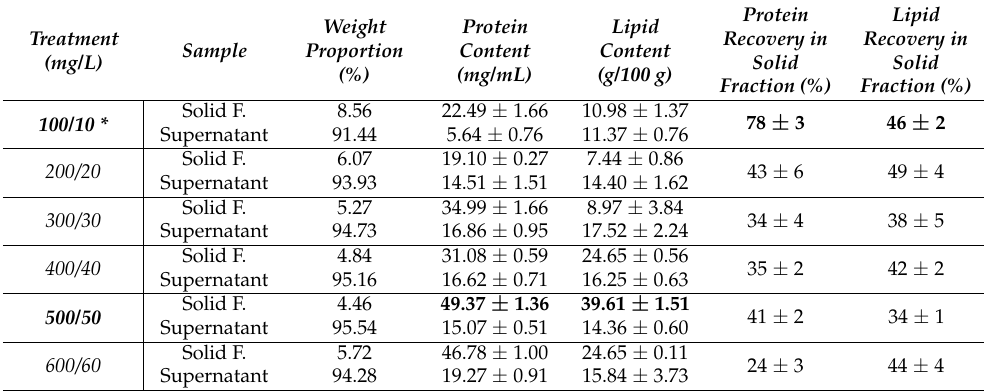
Table 5. Protein and lipid recovery obtained by coagulation/flocculation using different Chi- tosan/Alginate combinations. Analytical data are shown as mean ± SD (n =